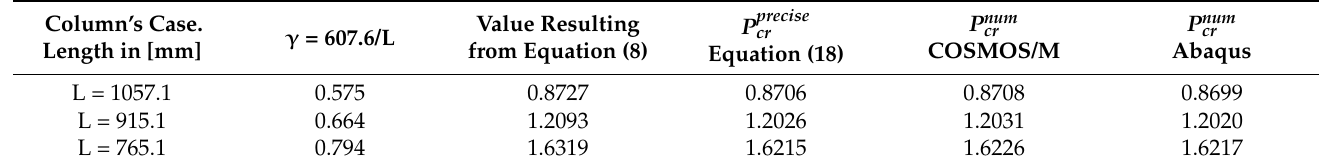
Table 6. Critical forces in [kN] for the case α =2.